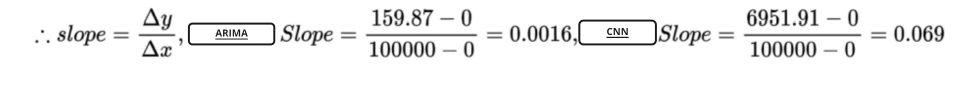
Figure 24. The slope